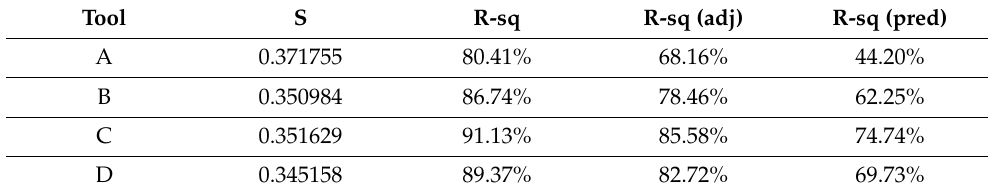
Table 5. Model summary for ANOVA table for Tools A, B, C and D. Tool